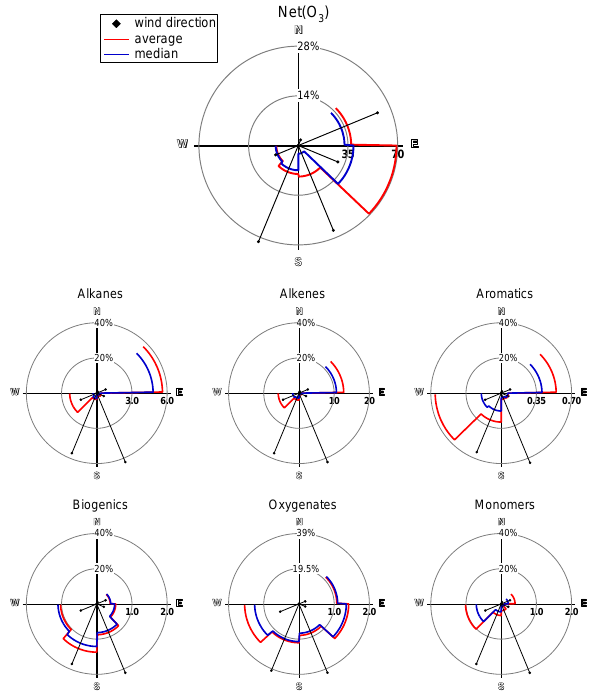
Fig. 10. Net( O 3 ) (in ppb / h ) and OH reactivity of VOC classes (in s − 1 ) as function of local wind direction in Barbours Cut during TexAQS 2006. The values on the x -axis are the medians (blue) and the averages (red); the values on the y -axis indicate the frequency of the wind direction.